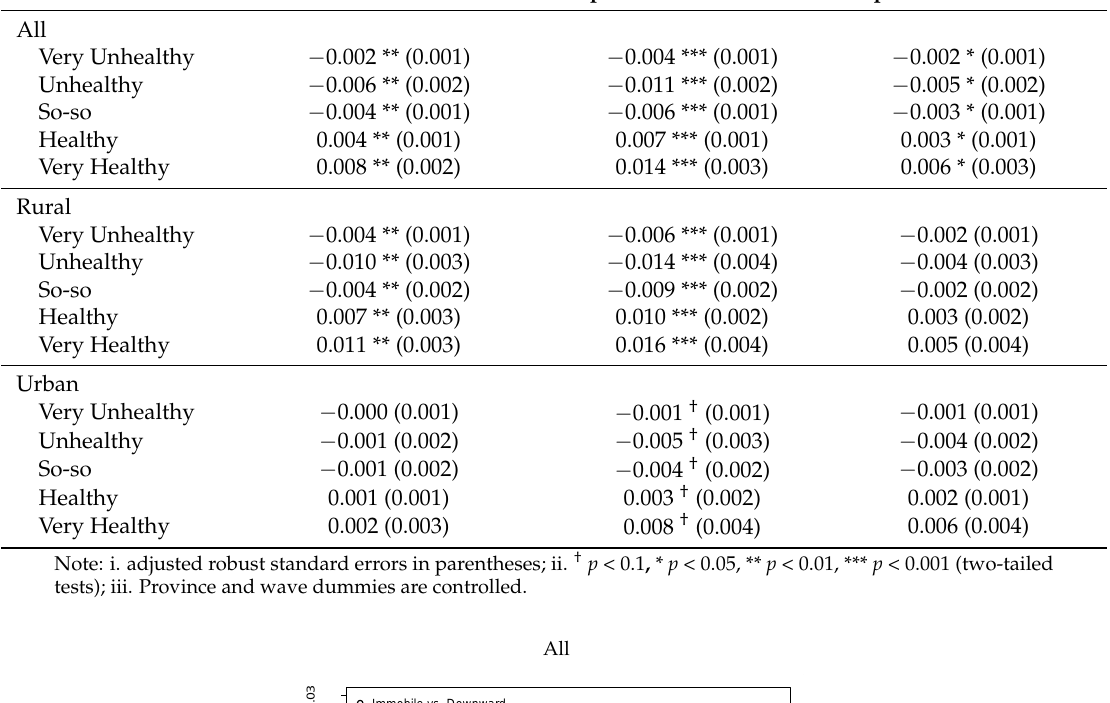
Table 5. Average Partial Effect of Self-Perceived Mobility. Immobile vs. Downward Upward vs. Downward Upward vs. Immobile All